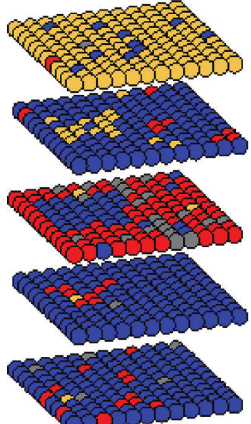
Figure 10: E ff ect of the (U,Si) local ordering on Al di ff usion. In agreement with the atom-by-atom analysis, the Si atoms have an increased stopping power if they are located in subsurface U-rich